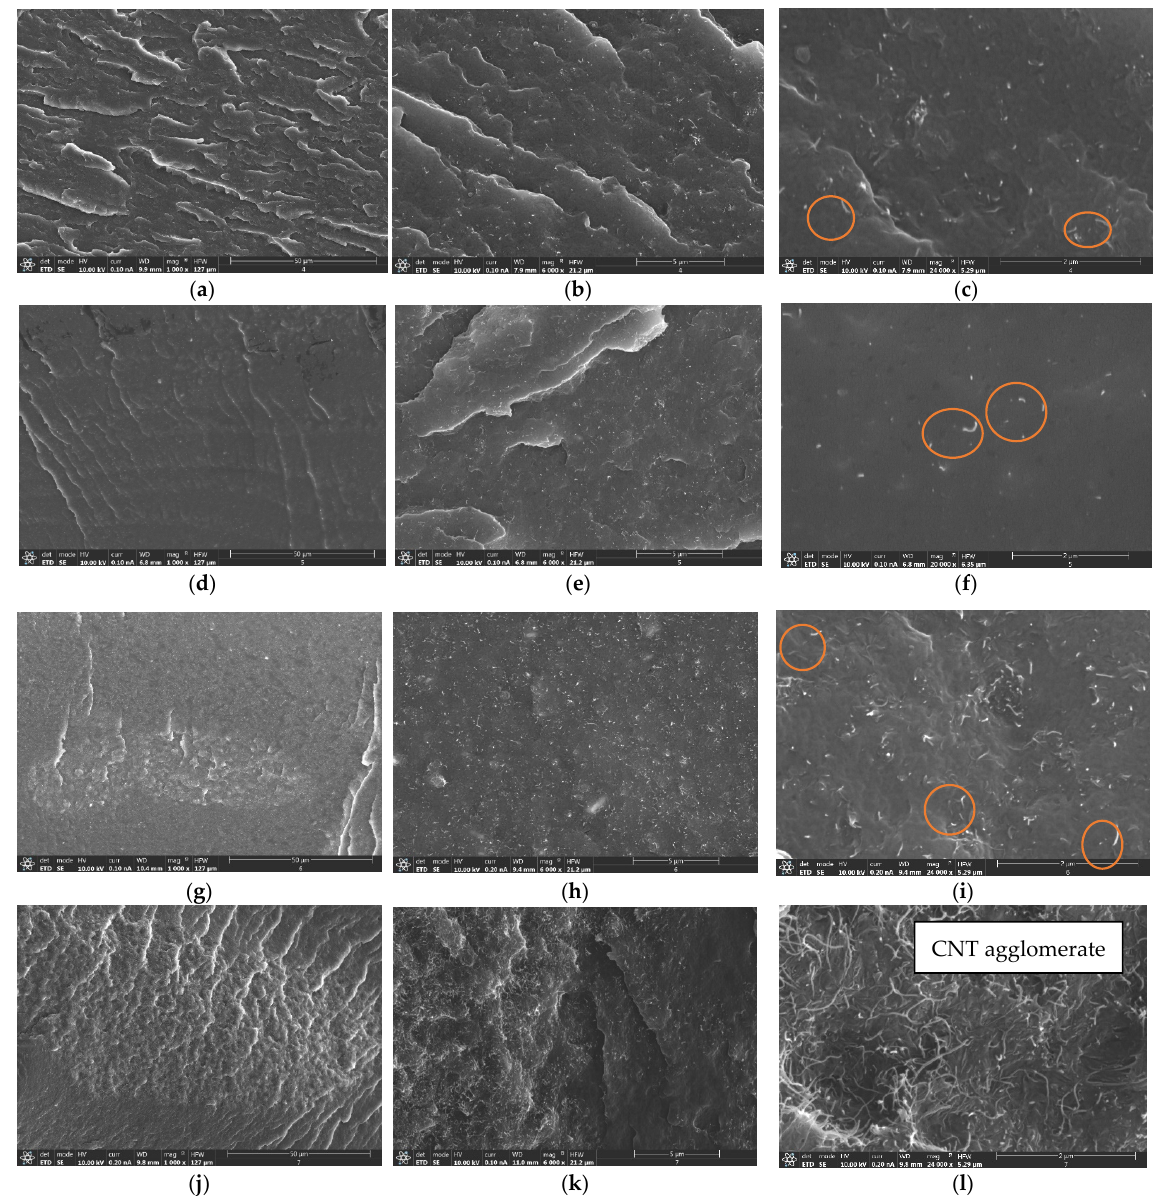
Figure 4. FEG-SEM images of the CNT–Surlyn nanocomposites at ( a – c ) 4, ( d – f ) 5, ( g – i ) 6, and ( j – l ) 7 wt.% CNT. The left, center, and right images are at 1000, 6000, and 24,000 magnifications, respec- tively.